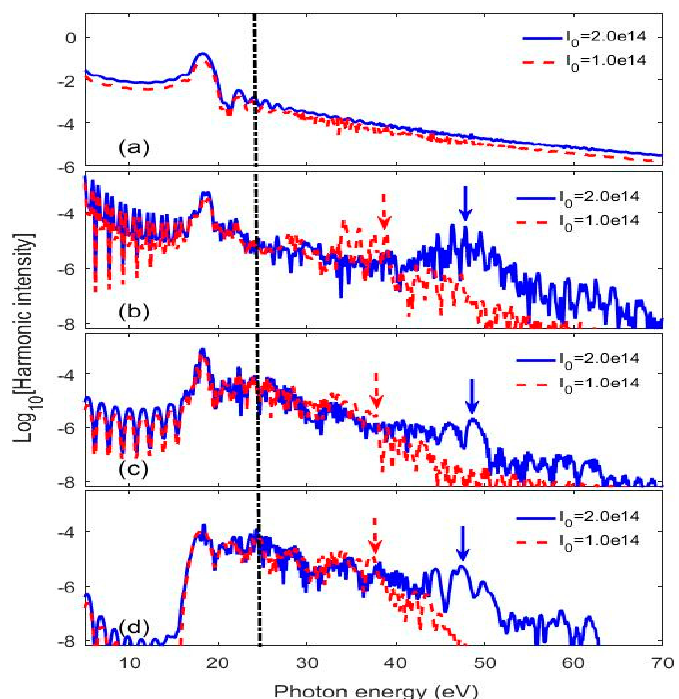
Figure 2. High-order harmonic spectra generated by a laser field with a constant amplitude ( a ), trapezoidal ( b ), gaussian ( c ), and sine-squared ( d ) envelopes. Two different intensities of the laser field (2.0 × 10 (cid:2869)(cid:2872) W/cm (cid:2870) and 1 .0 × 10 (cid:2869)(cid:2872) W/cm (cid:2870) ) are considered. Other parameters are the same as used in Figure. 1.